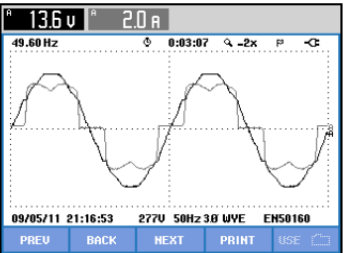
Figure 11. Grid voltage and current with inductive load and without any filtering action.